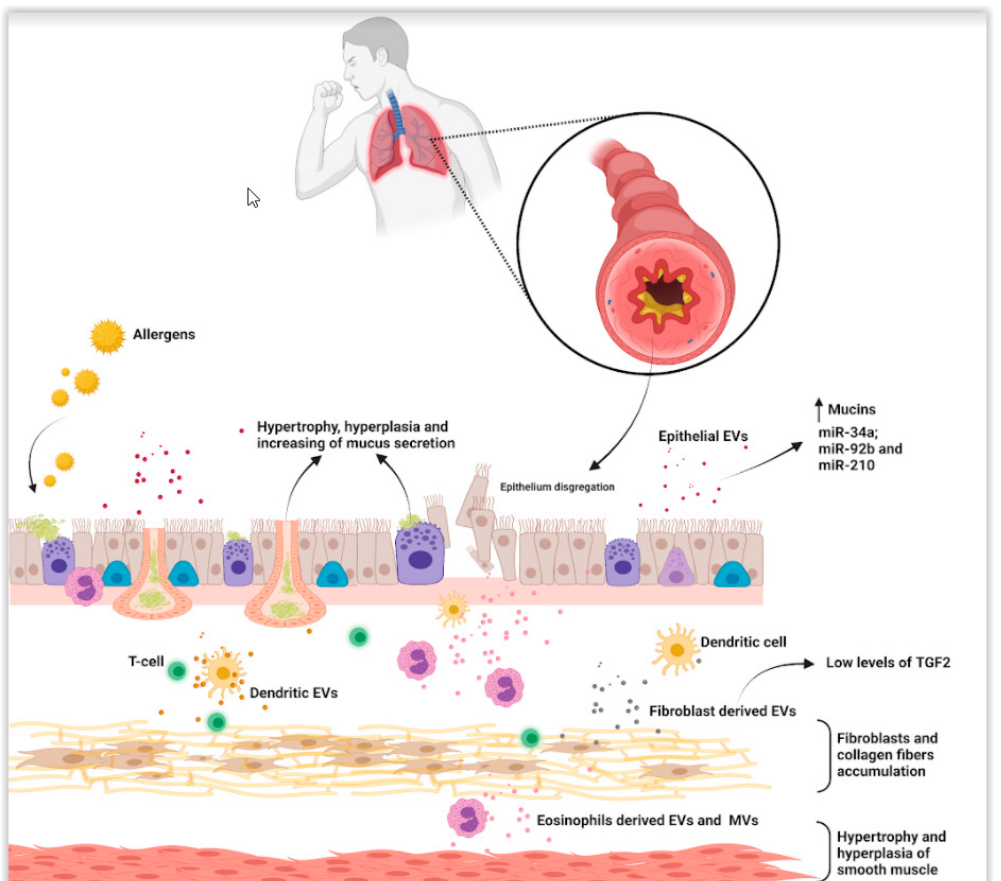
Figure 1. Scheme of allergic asthma pathogenesis. Allergic asthma is triggered by inhaling allergens. (Allergens could have different origins such as dust mites, pet dander, pollen or mold.) During the different phases and chronicization of the pathology, the tissues undergo several modifications. Among these include hyperplasia, hypertrophy of mucous cells and an increase of their secretions, continuity loss of the epithelium and variation in EV content. The extracellular vesicular release appears incremented, modified and responsible for the alterations that occurred.